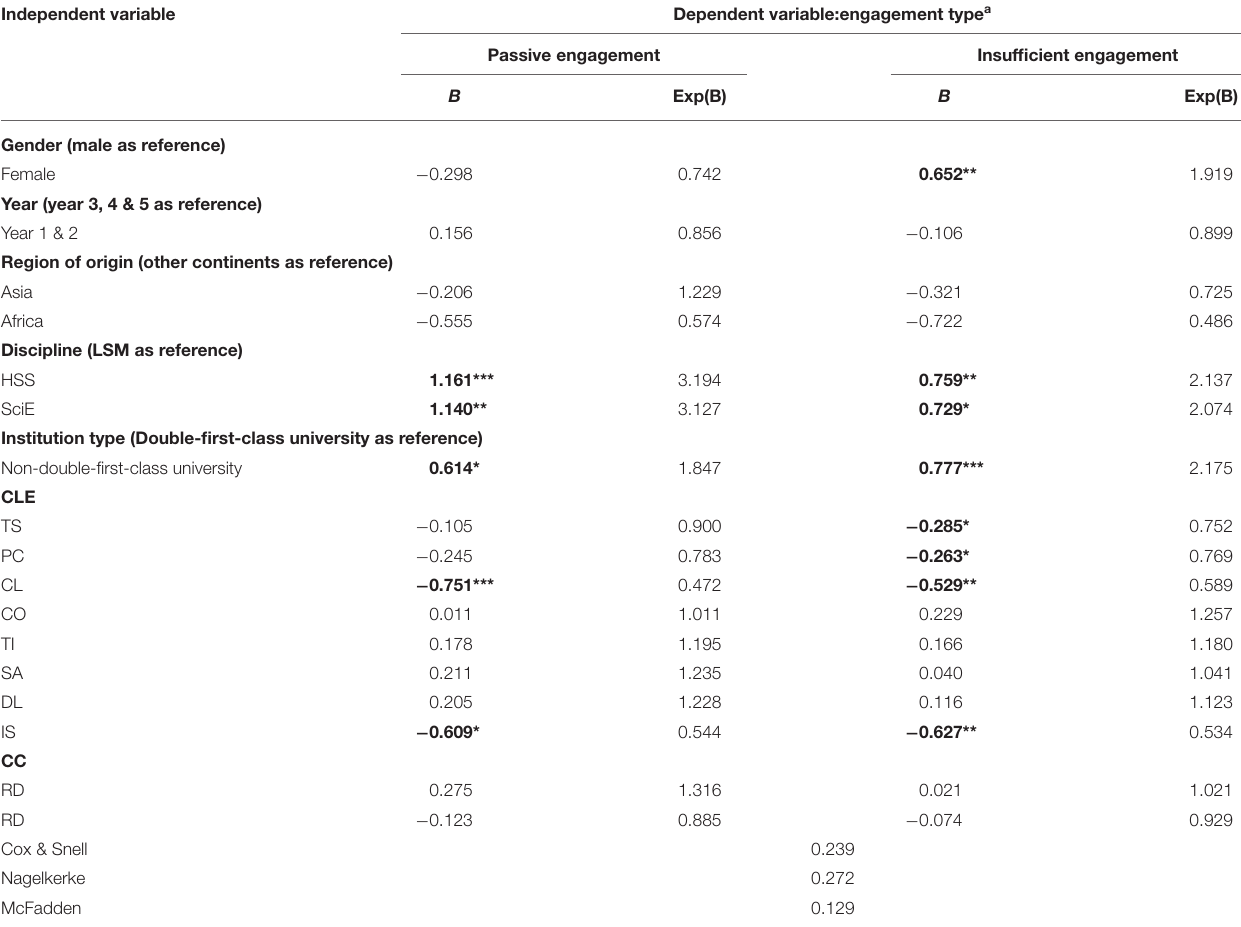
TABLE 6 | Multinomial logistic regression: factors predicting engagement types. Independent